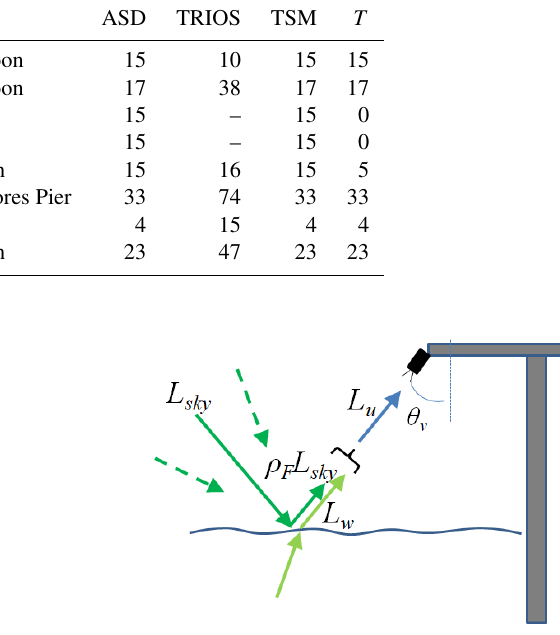
Figure 3. Instrument setup for L u ( a ) measurement.